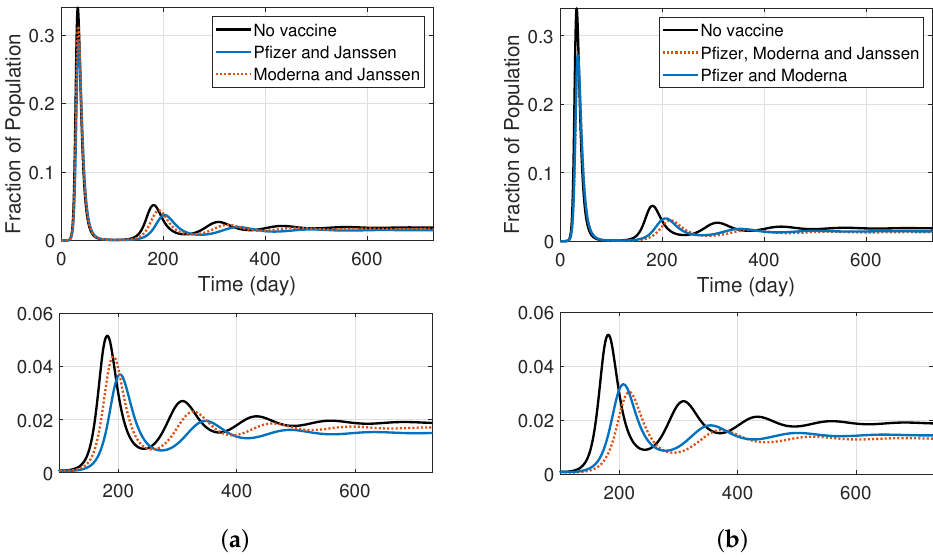
Figure 9. SIRS model with different vaccine types (model depicted in Figure 8); comparing the effect of vaccinating with various vaccines assuming that the average daily rate of vaccination by Pfizer is 0.3%, by Moderna is 0.15%, and by Janssen is 0.03%; ( a ) fraction of infectious population when individuals are vaccinated by Moderna and Janssen or Pfizer and Janssen; ( b ) fraction of infectious population when people are vaccinated by Moderna and Pfizer or by all three vaccines. Magnified versions of figures in the top row are represented in the second row (from the second